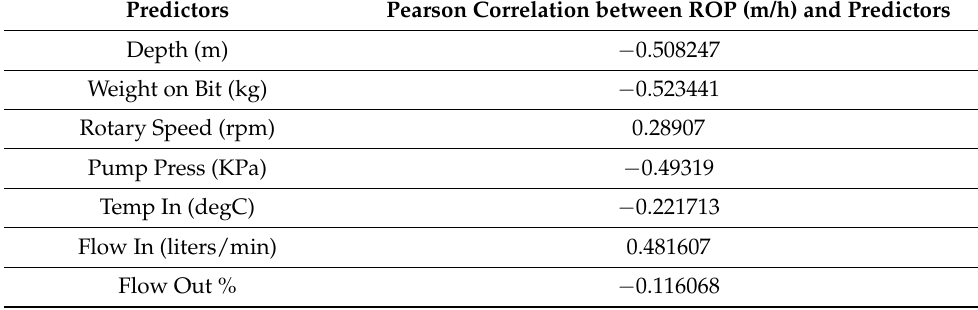
Table 2. Pearson correlation